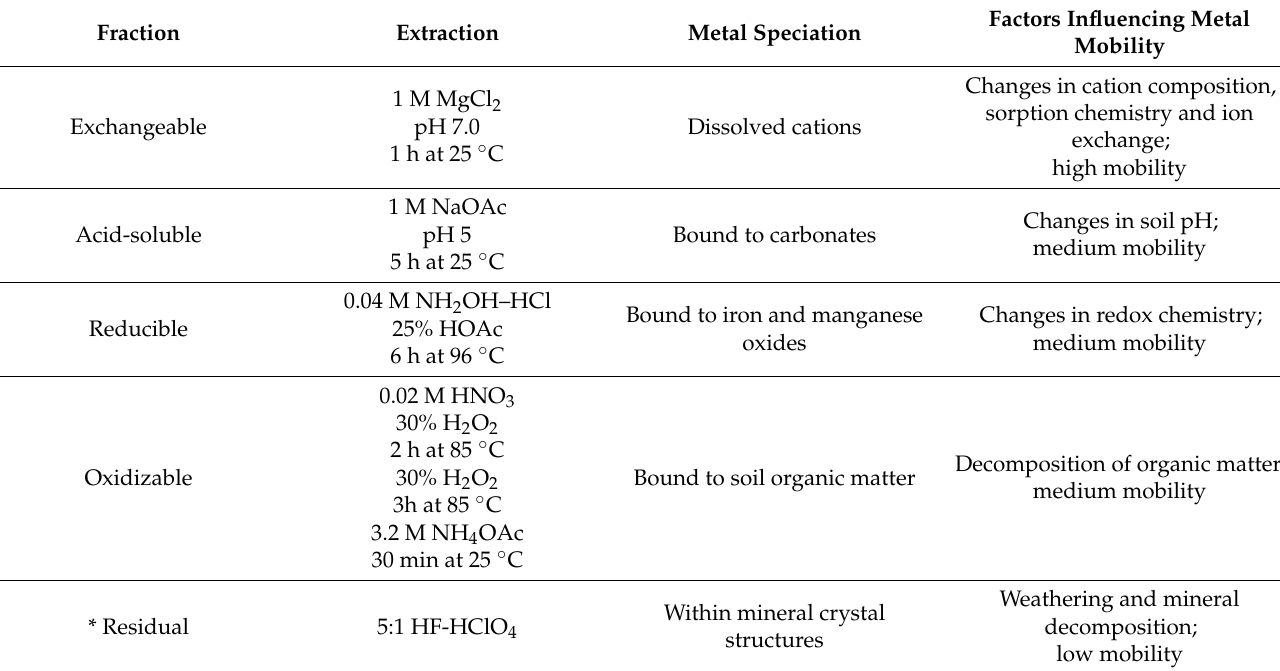
Table 2. The Tessier method for sequential extraction of soils, including the targeted soil fraction, extraction reagents and the predicted metal speciation and